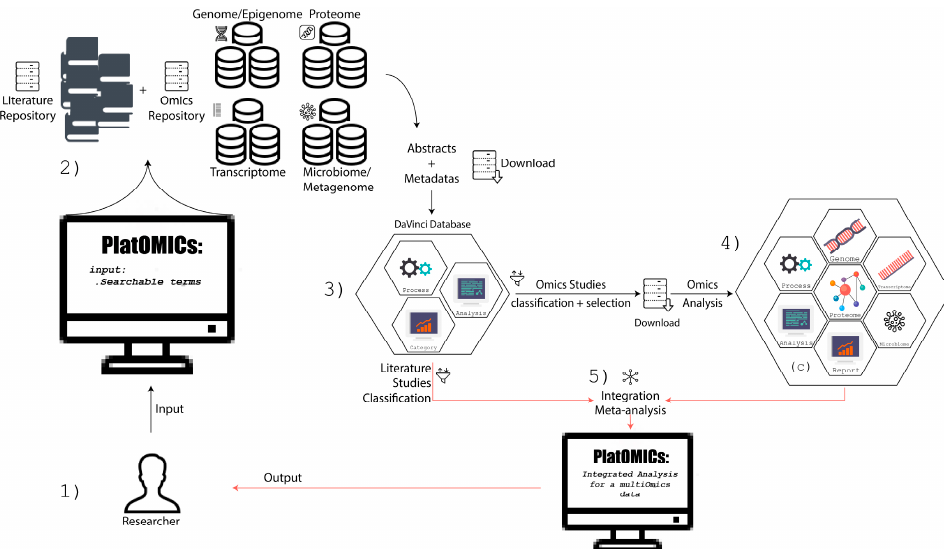
Figure 1. Workflow of omics Platform (PlatOMICs) for omics integration. ( 1 ). The user informs the descriptors, categorical terms, and keywords in PlatOMICs. ( 2 , 3 ) Through DaVinci tool, the literature and the omics databases will be evaluated. ( 4 ) Selected omics studies and new ones are (re)analyzed and integrated by standard pipelines. ( 5 ) PlatOMICs produces final meta-analysis–multiomics integration results in a friendly interface.